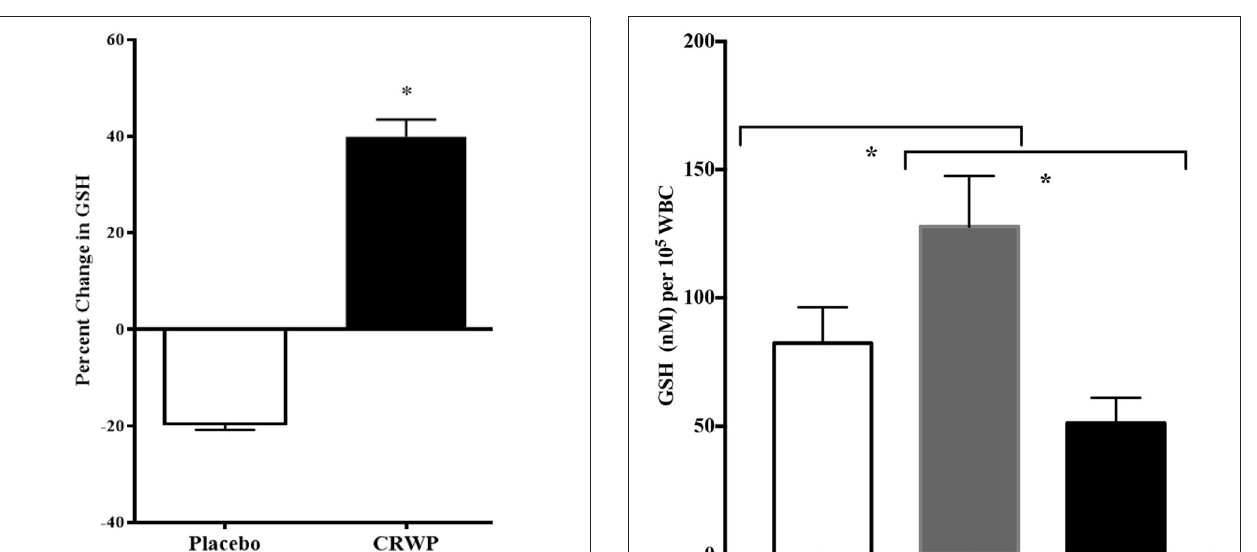
in the communication domain score ( p = 0.008 and p = 0.01 compared to non-responders and placebo, respectively), with differences noted in the receptive V-scale score ( p = 0.01 compared to non-responders), and the expressive v-scale score ( p = 0.03 compared to non-responders); in the daily living skills domain score ( p = 0.008 and p = 0.007 compared to non-responders and placebo, respectively) with differences observed in the personal v-scale score ( p = 0.03 and p = 0.004 compared to non-responders and placebo,